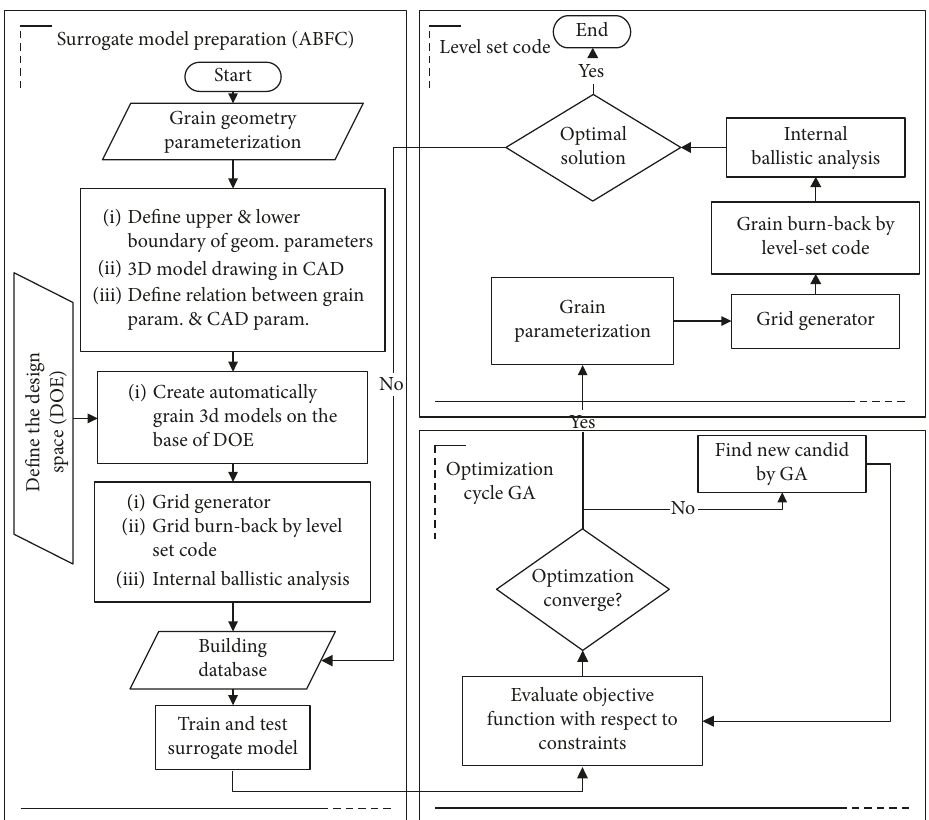
Figure 4: Optimization process of 3D geometry grain design by GA based on a surrogate